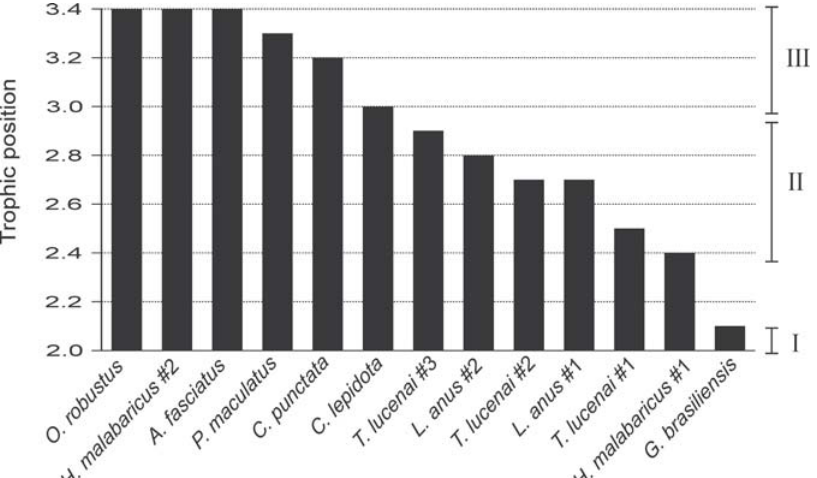
Fig. 3. Trophic position estimates of fishes collected at Nicola Lake, Taim Hydrological System. # symbols denotes different individuals of the same